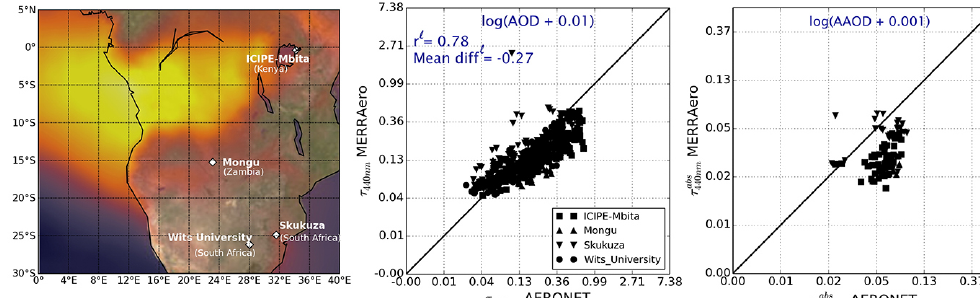
Figure 10. Same as Fig. 5 but for the southern African region.